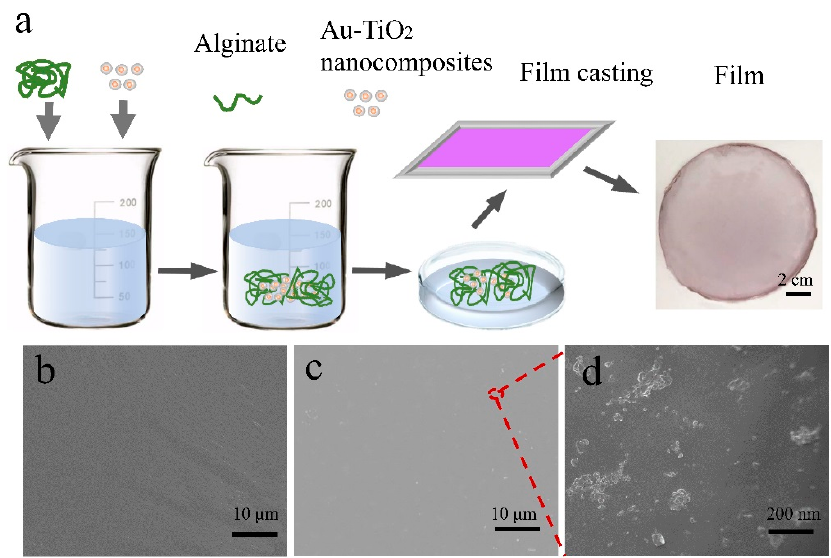
Figure 2. ( a) Schematic illustration of the fabricating process of the Au-TiO 2 nanocomposite film; SEM images of ( b ) pure alginate film and ( c , d ) Au-TiO 2 nanocomposite film.